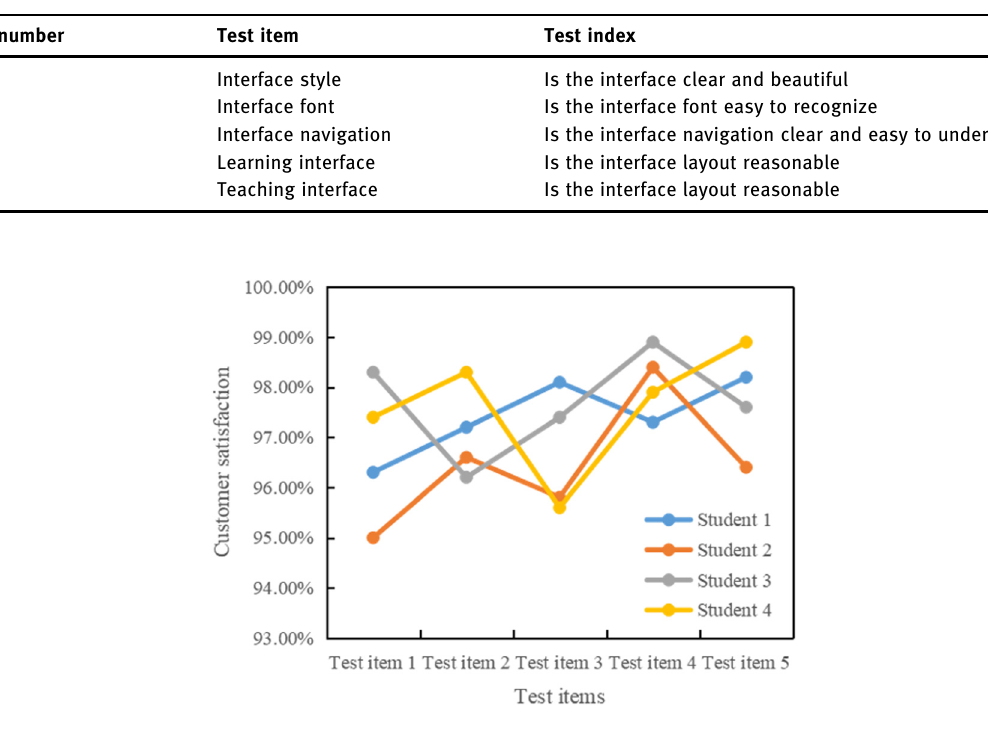
Figure 6: User interface satisfaction test chart.